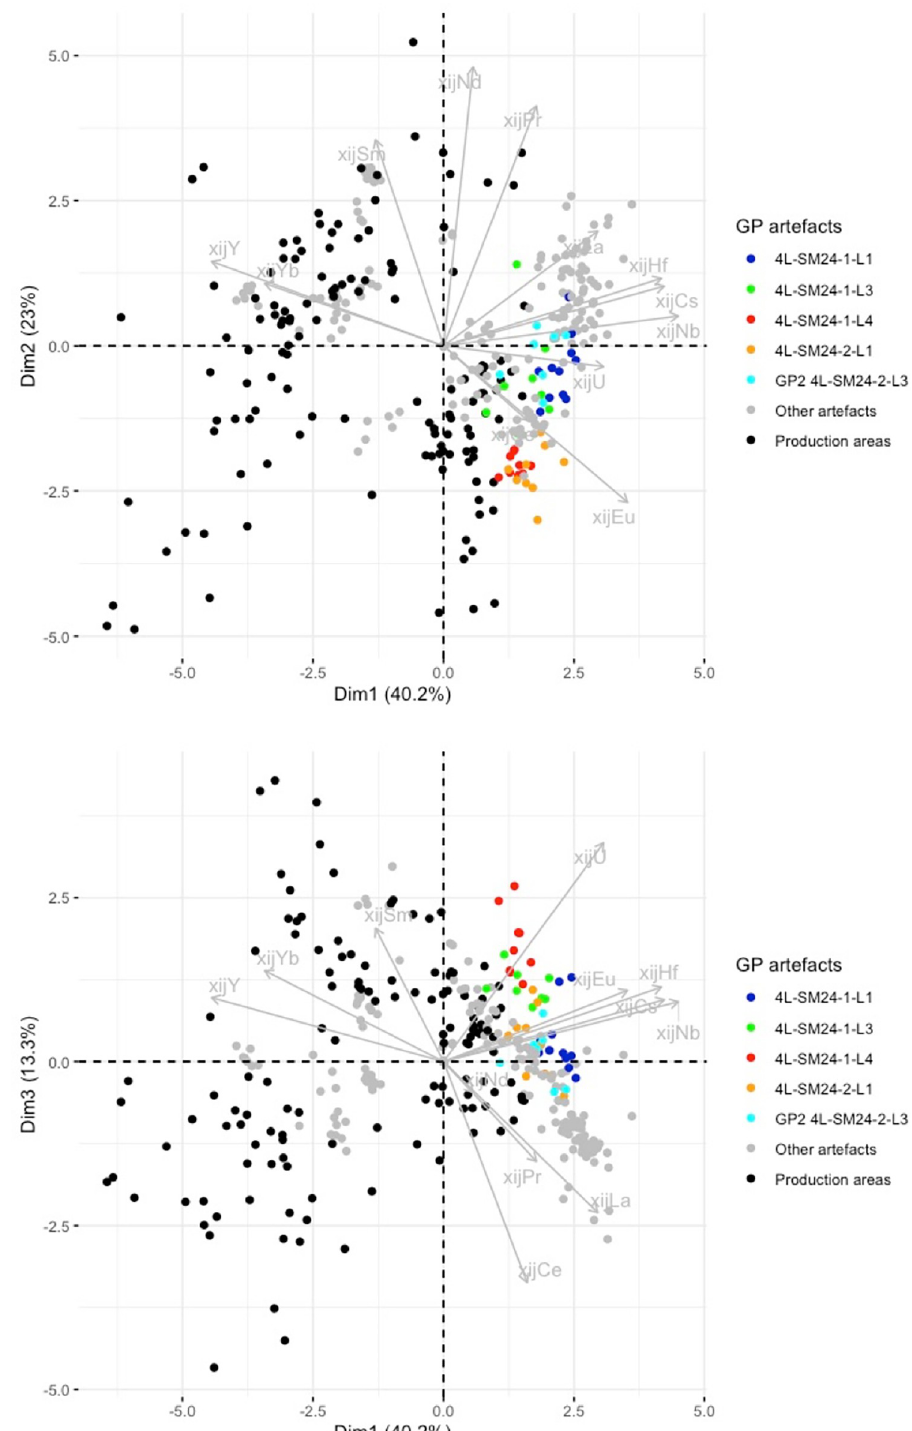
Fig 15. PCA on xij of production area slag. Artefacts of Group GP and GP2 are coloured (each colour corresponds to an artefact. Production areas are presented in black. % between brackets: % of total variance.